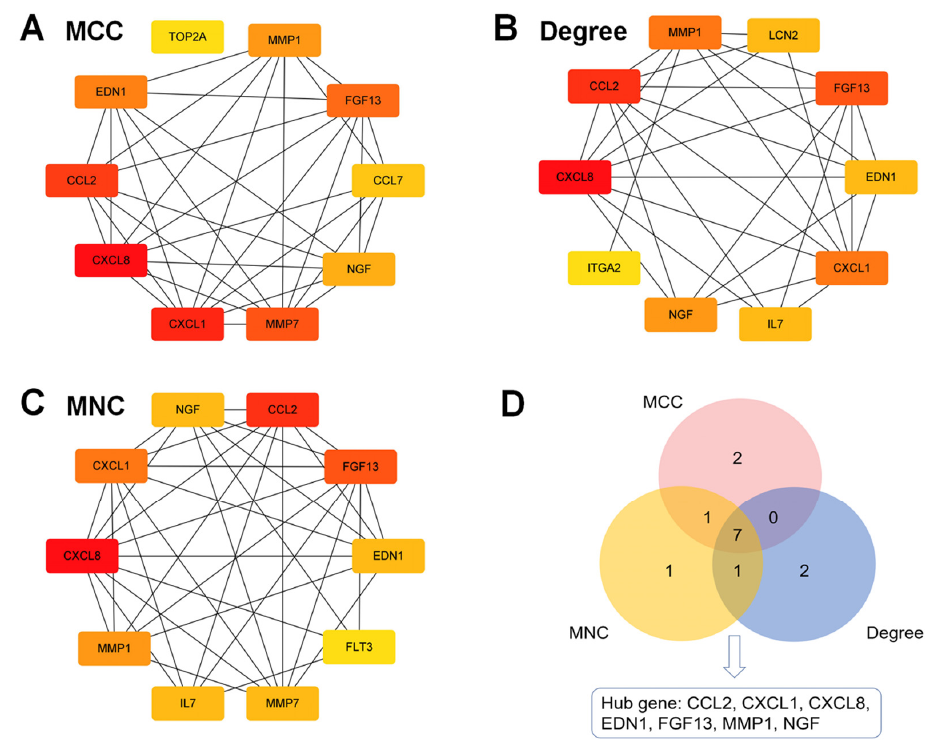
Figure 4. Hub genes in the PPI network by DCC ( A ), Degree ( B ), and MNC ( C ). The Venn diagram illustrates seven hub genes screened by three algorithms ( D